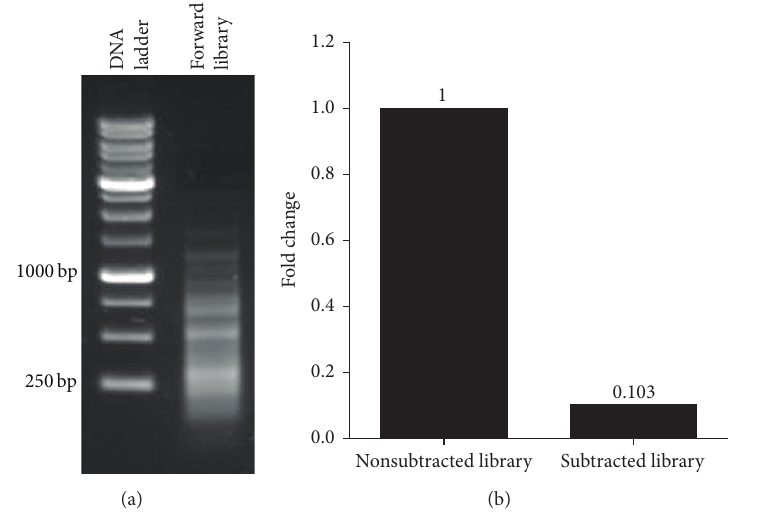
Figure2:ConstructionoftheSSHlibrary.(a)Forwardconstructedlibrary(Lane2),whichrangesinlengthfrom180to1200 bp.(b)Evaluation of the subtraction efficiency of the constructed library. The relative expression levels of the beta actin gene in the two samples indicate that there is a 9.7-fold decrease in beta actin expression in the subtracted